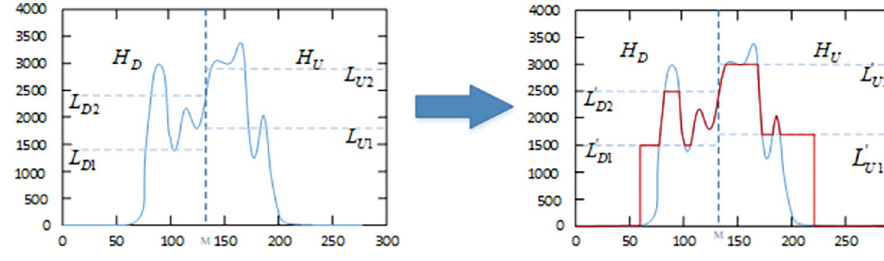
Fig 7. Histogram